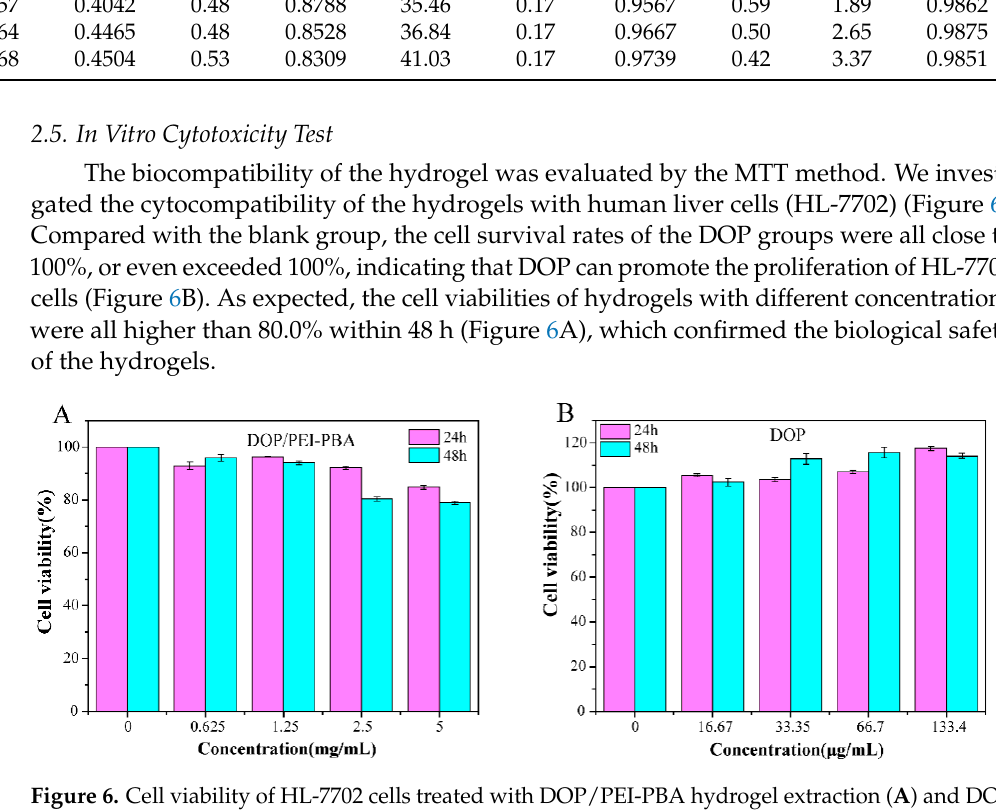
Figure 6. Cell viability of HL-7702 cells treated with DOP/PEI-PBA hydrogel extraction ( A ) and DOP ( B ) in different concentrations at 24 h and 48 h.